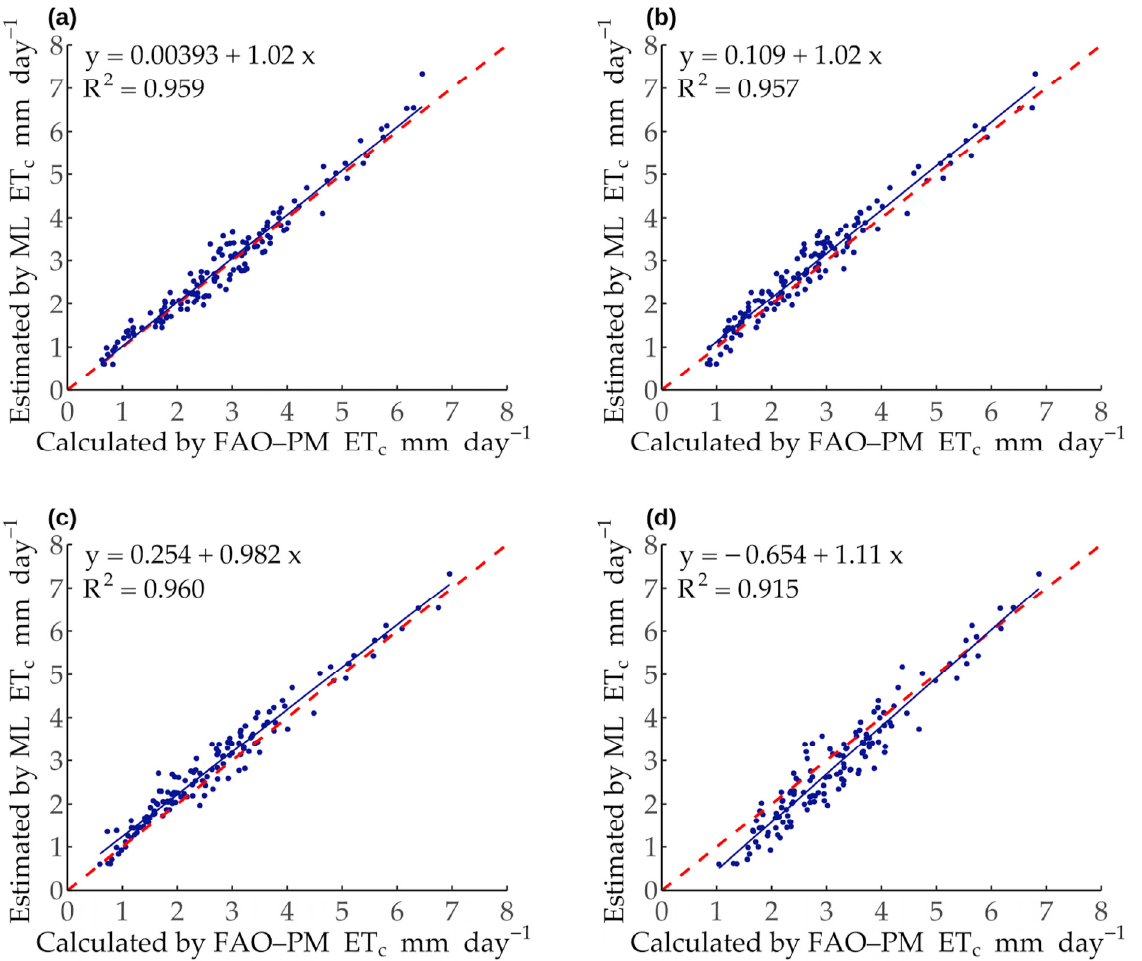
Figure 4. Scatter plots of calculated daily spring maize ET c values by FAO–PM method compared with ML model-estimated values with K c , T ave , T max , n and RH as the input. RF–SVR–PSO model ( a ), SVR model ( b ), BPNN model ( c ) and RF model ( d ).